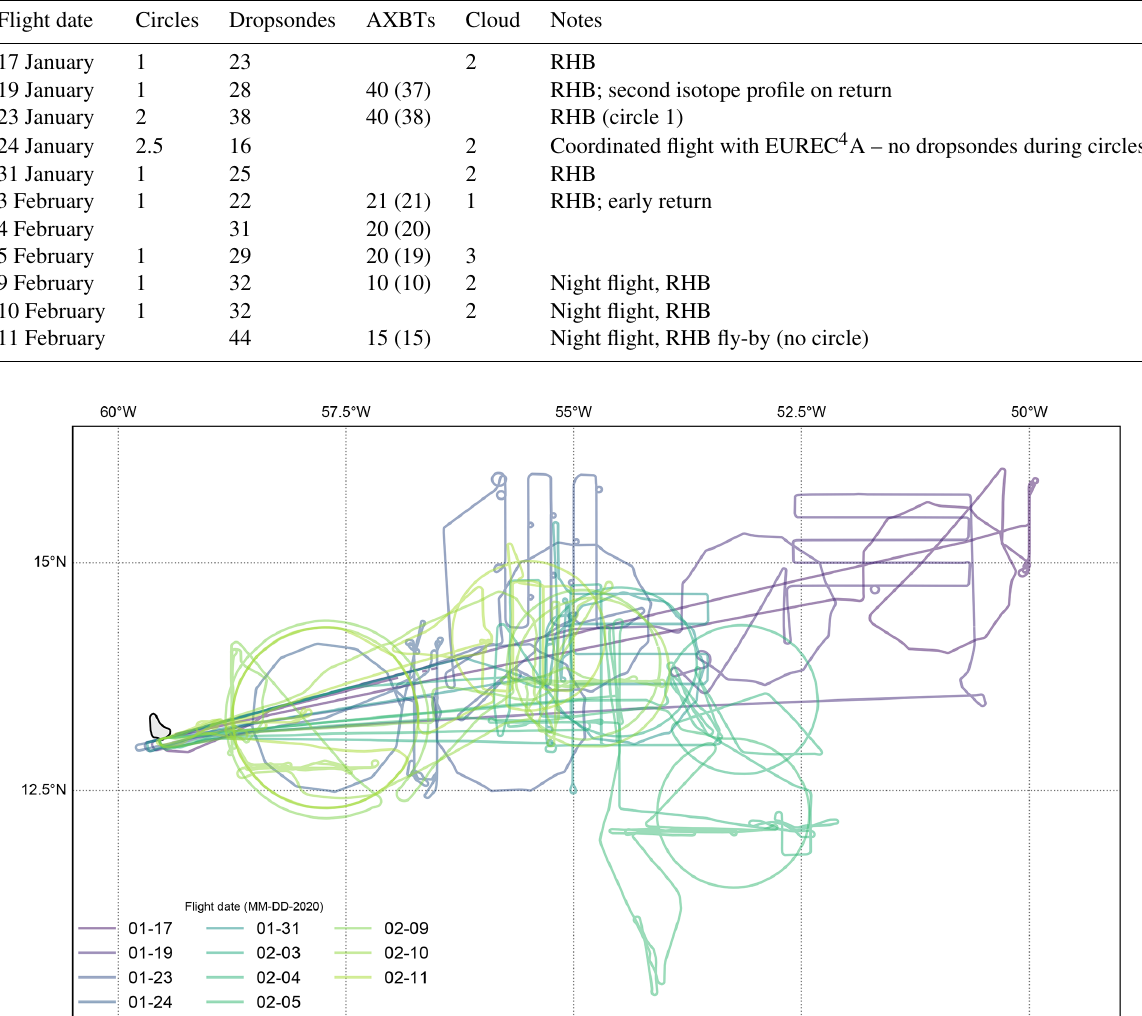
Table 1. Flight sampling strategies employed on each flight by the P-3 during ATOMIC. Flight date is UTC and most flights were 8–9h long. Numbers in parentheses show the number of AXBTs for which valid data were obtained. “RHB” indicates that the R/V Ronald H. Brown was at the center of a dropsonde circle. Most AXBT patterns deployed 20 instruments. “Cloud” indicates the number of cloud patterns flown; each typically involved sampling at four or five altitudes. See also Table 3 of Quinn et al. (2021). Detailed reports from each flight are available at the EUREC 4 A data portal (https://observations.ipsl.fr/aeris/eurec4a/, last access: 11 June 2021).